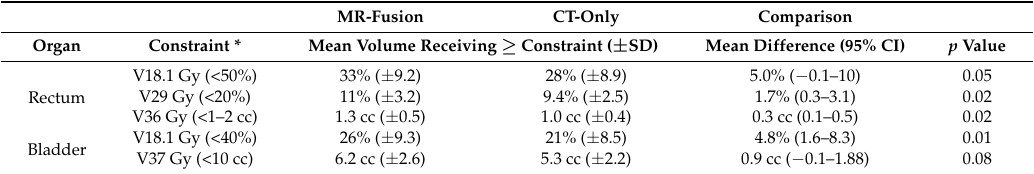
Table 5. Organ-at-risk doses for MR-fusion and CT-only